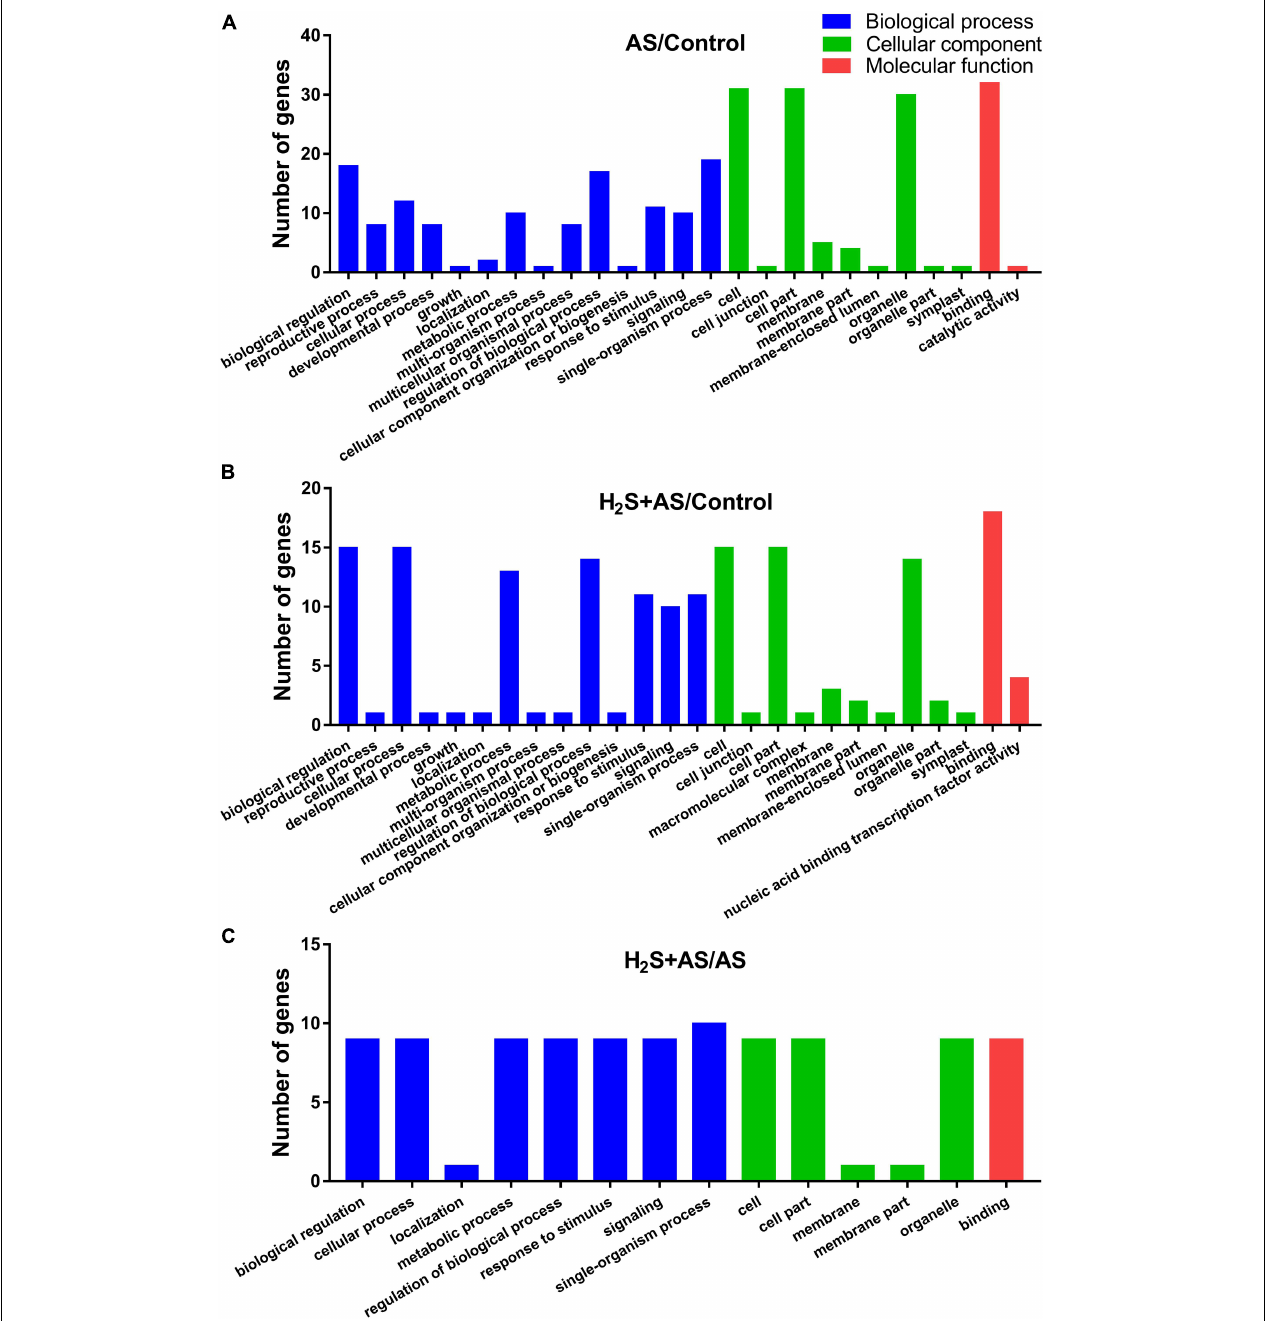
FIGURE 5 | Gene ontology classification of predicted target genes for the identified miRNAs. Blue, green, and red represent three GO ontologies: biological process, cellular component, and molecular function, respectively. (A) Number of genes under AS stresses as compared with control treatment; (B) number of genes under H 2 S + AS stresses as compared with control treatment; (C) number of genes under H 2 S + AS stresses as compared with AS